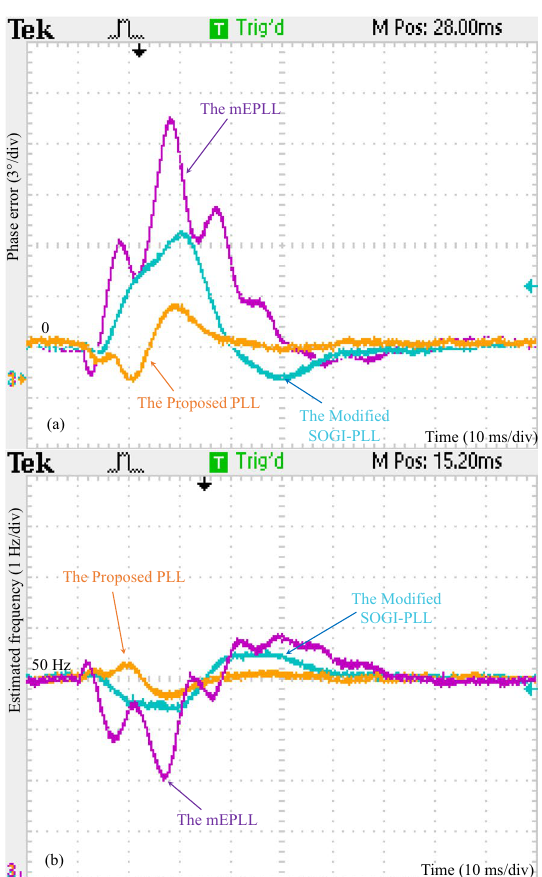
Fig. 16 Experimental results under a 20% voltage sag. CH1, CH2, and CH3 the proposed PLL, mEPLL, and modified SOGI-PLL, respectively. a